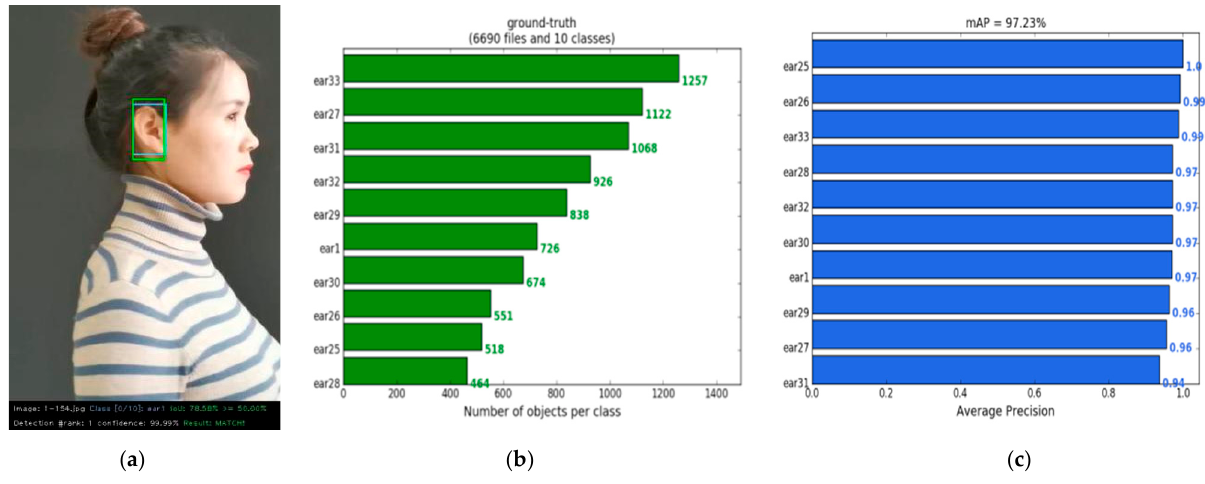
Table 12. The test video selection and frame cut. Figure 8. Performance index test results. ( a ) IOU; ( b ) the number of real frames of various human ear targets; ( c ) mAP.